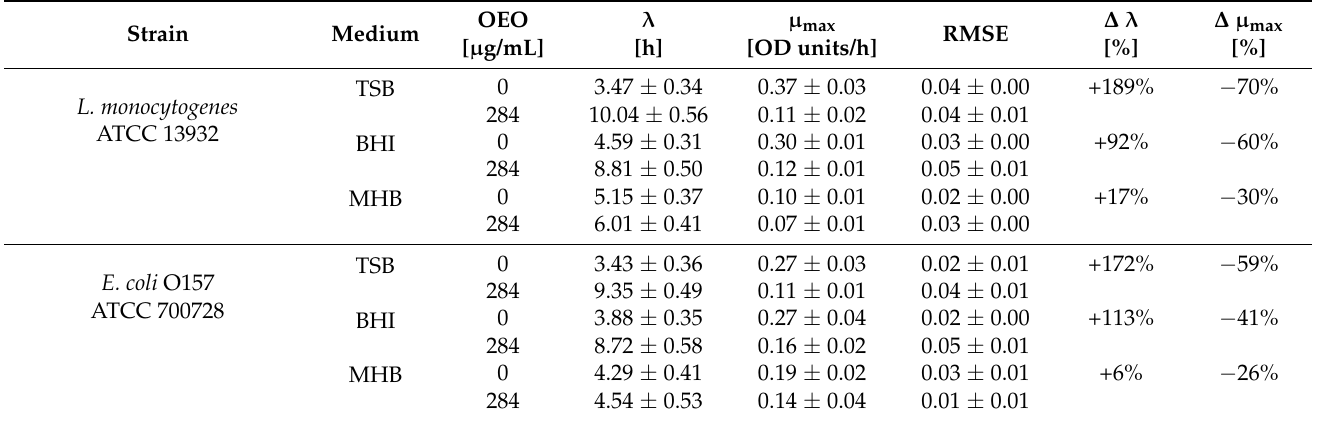
Table 3. Comparison of growth model parameters for various media (mean ± SEM of three